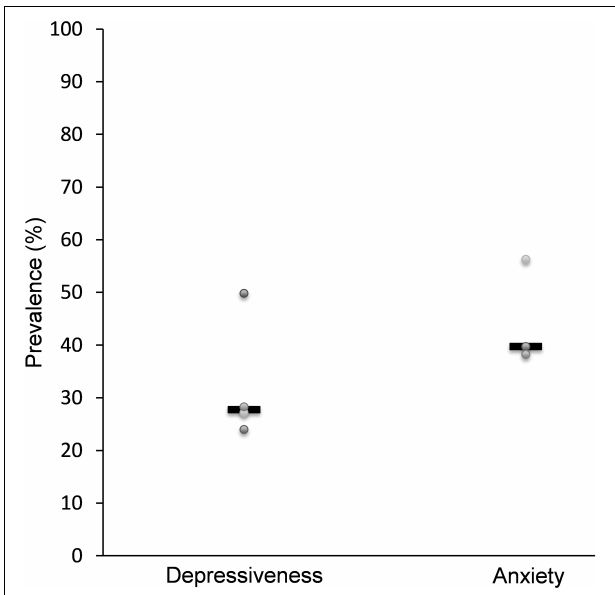
FIGURE 2 | Studies assessing the prevalence of depressiveness and anxiety in patients with hepatocellular carcinoma. Data for depressiveness ( n = 799 patients) are based on Mikoshiba et al. (2013), Cheng et al. (2019), Jia et al. (2019), and Wang et al. (2019), for anxiety ( n = 515 patients) on Liu et al. (2017), Jia et al. (2019), and Wang et al. (2019).